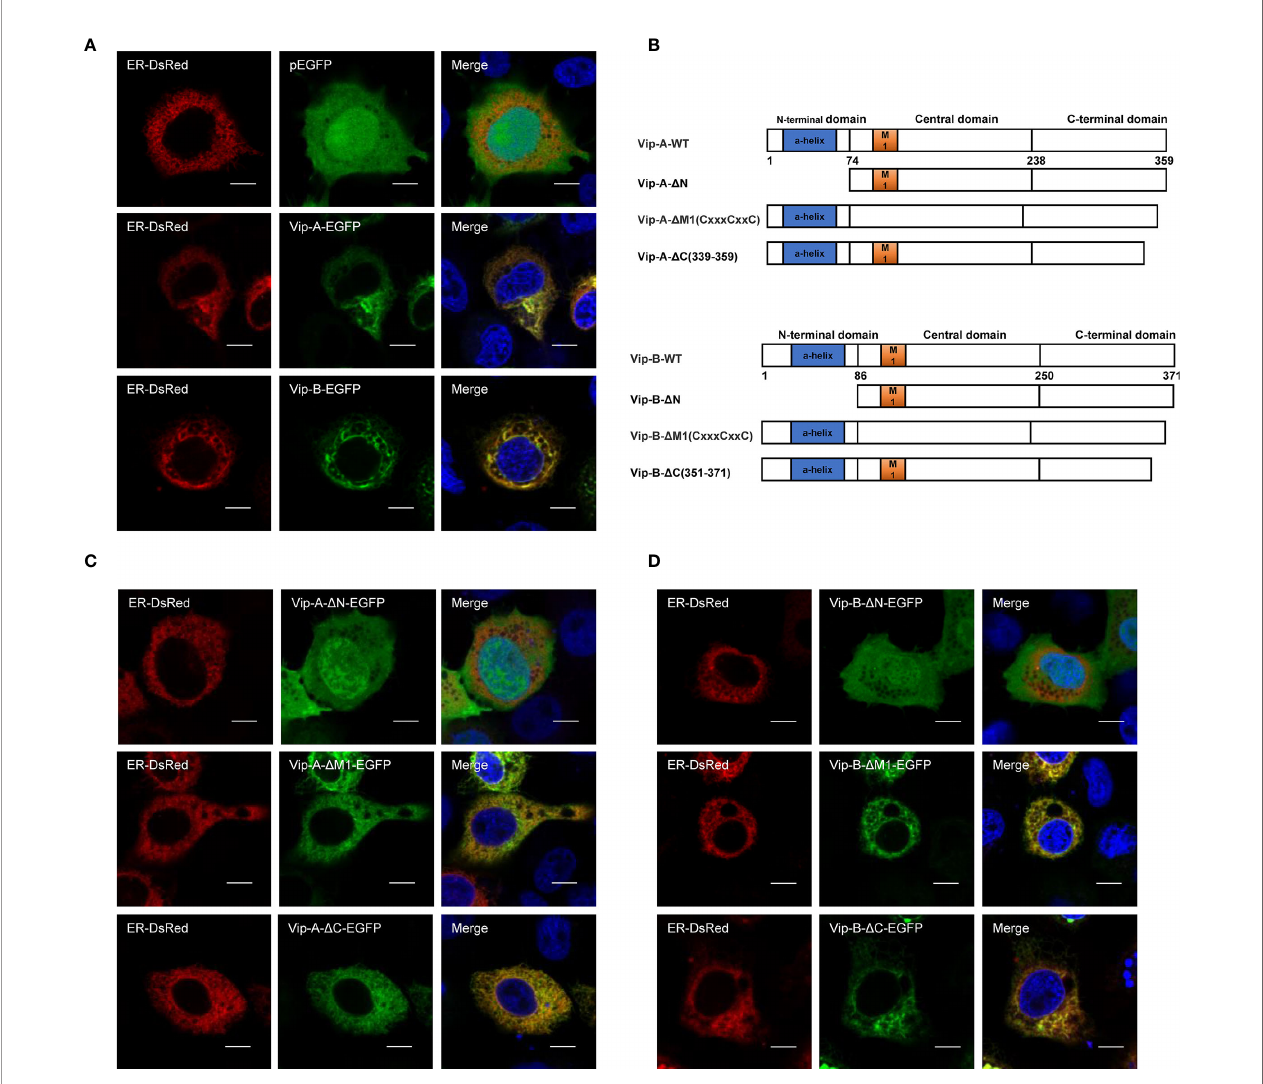
FIGURE 3 | Cg Viperin-A and Cg Viperin-B colocalize at ER through N-terminus domain. (A) Subcellular localization of WT Cg Viperin-A, Cg Viperin-B, and ER-DsRed. CAB cells were plated onto coverslips in six-well plates and co-transfected Cg Viperin-A-EGFP or Cg Viperin-B-EGFP with ER-DsRed. After 24 h, the cells were fi xed and observed under confocal microscopy. Nuclear was stained with DAPI. Scale bars = 5 m m. (B) Diagrammatic representation of WT and three mutants of Cg Viperin-A or Cg Viperin-B. (C, D) Subcellular localization of three mutants of Cg Viperin-A (C) or Cg Viperin-B (D) with